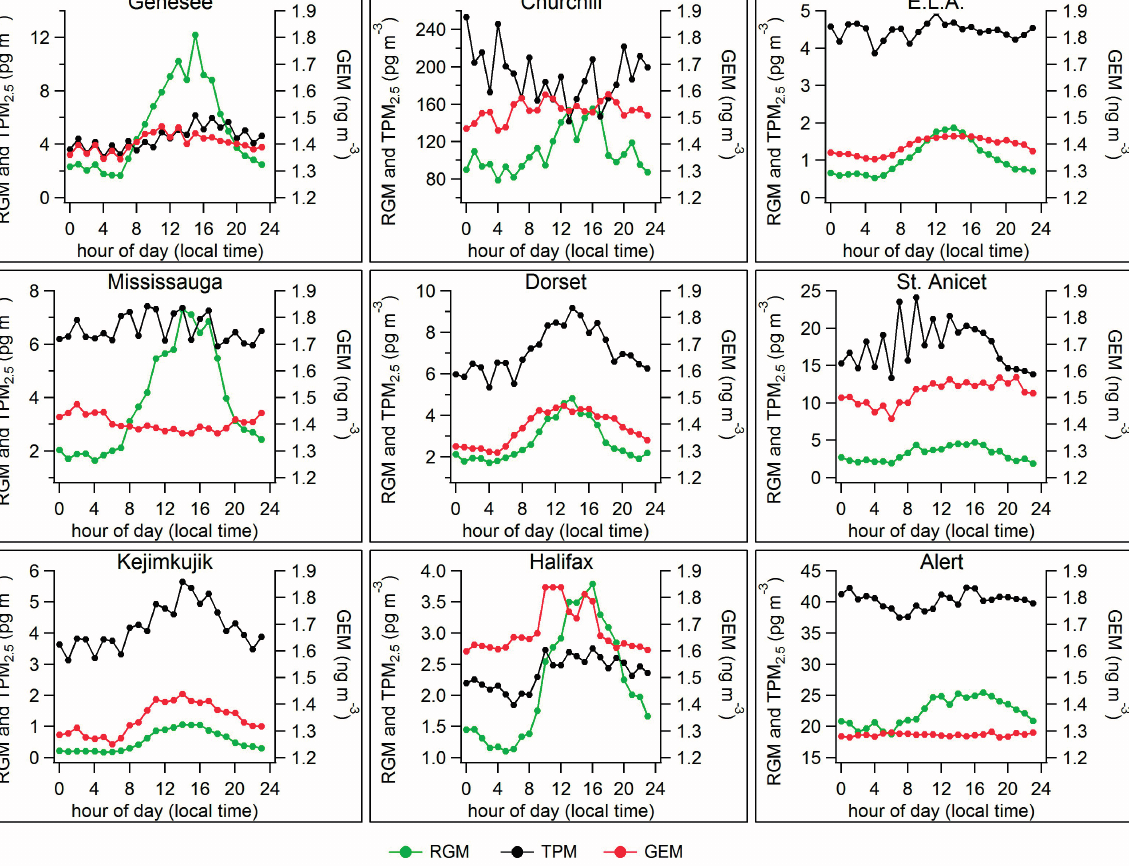
(mean concentrations 2.5 2.5